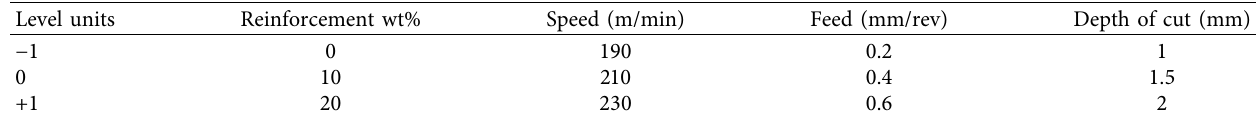
Table 3: Input factors and their